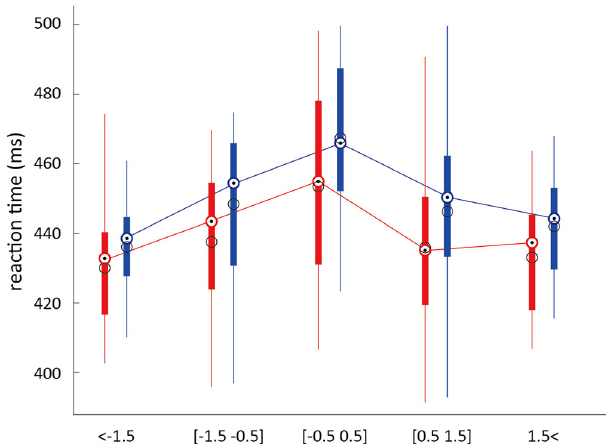
Fig. 5 Embodiment improves main (right-hand) task performance. The reaction times for the right-hand button press were collected from the EMB (red data) and no-EMB (blue data) conditions into time bins aligned to the left-hand ca-button presses. A two-way ANOVA showed a signi fi cant main effect of conditions ( F (1,23) = 8.061, P < 0.005, η 2 = 0.037), and main effect of time bin ( F (4,92) = 20.297, P < 10 − 13 , η 2 = 0.281). Embodiment of the left arm improved performance by the right hand. The black circles show the mean and the colored circle with the dot shows the median scores across participants. The box edges show the 25th and 75th percentile of the data and the whiskers show the data